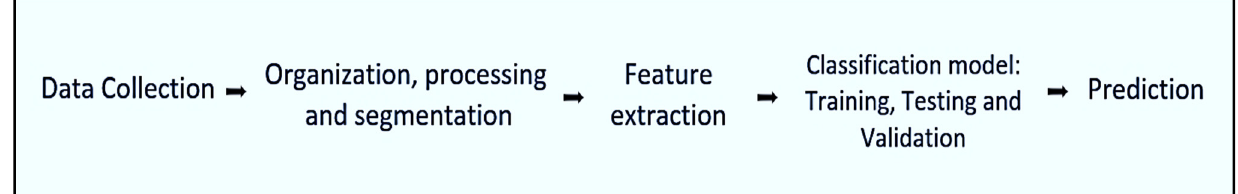
Figure 2. Process flow of computer vision-based classification methods.